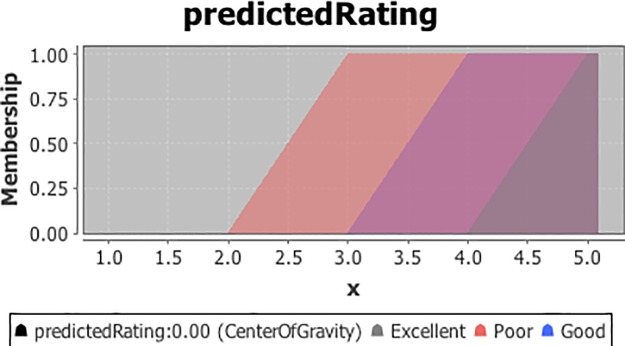
Membership function for the output variable ‘predicted rating’.